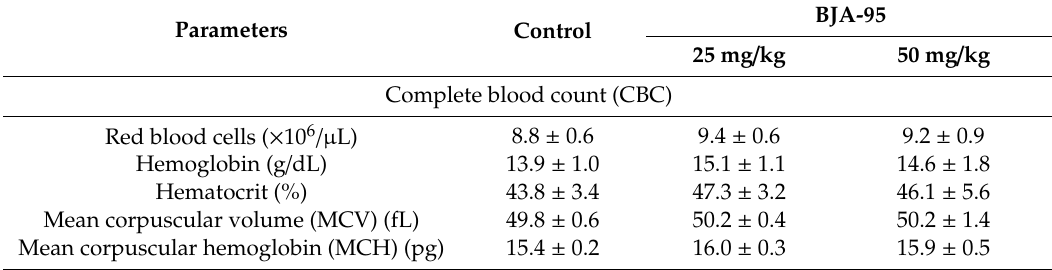
Figure 6. BJA-95 inhibited CCA growth in vivo. ( A ) Relative tumor volume. ( B ) Representative photos of the tumor mass. ( C ) Tumor weight of treatment groups compared to the control group. ( D ) Body weights of mice. ( E ) Hematoxylin and eosin (H&E) staining of tumor tissues. ( F ) Percentage of necrotic area in tumor tissues and ( G ) viable tumor mass. Results are shown as mean ± SD values ( n = 5). (*) p < 0.05 and (**) p < 0.01 when compared with the control group. Table 2. Complete blood count and blood chemistry of mice treated with BJA-95 compared with